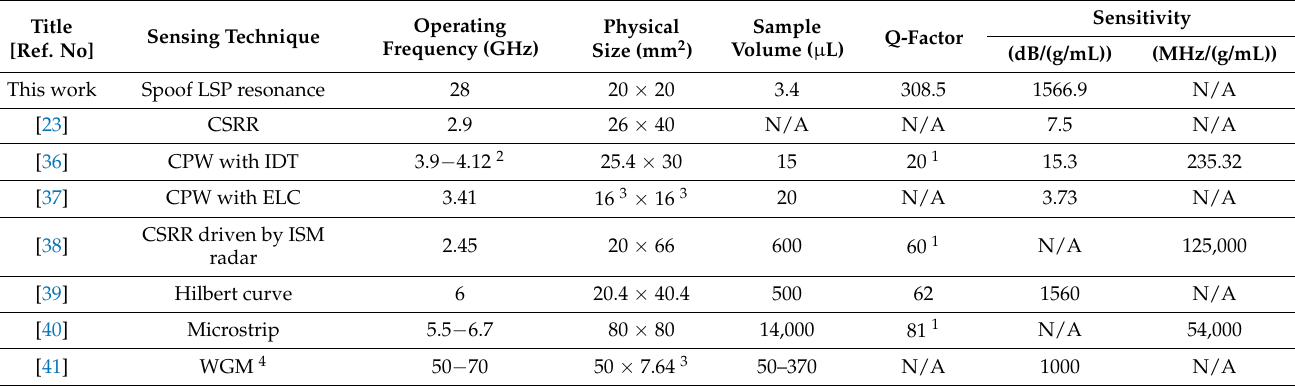
Table 2. Comparison with state-of-the-art glucose sensors.